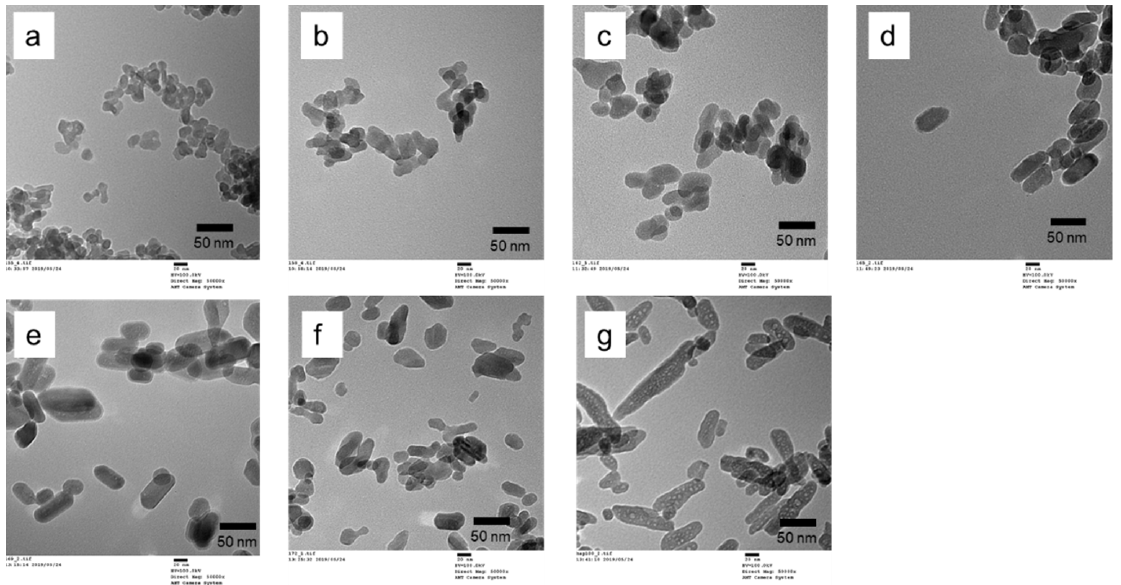
Figure 1. Powder X-ray diffraction (XRD) patterns of hydroxyapatites ( a ) as-prepared and ( b ) after conversion of 1,6-hexanediol.